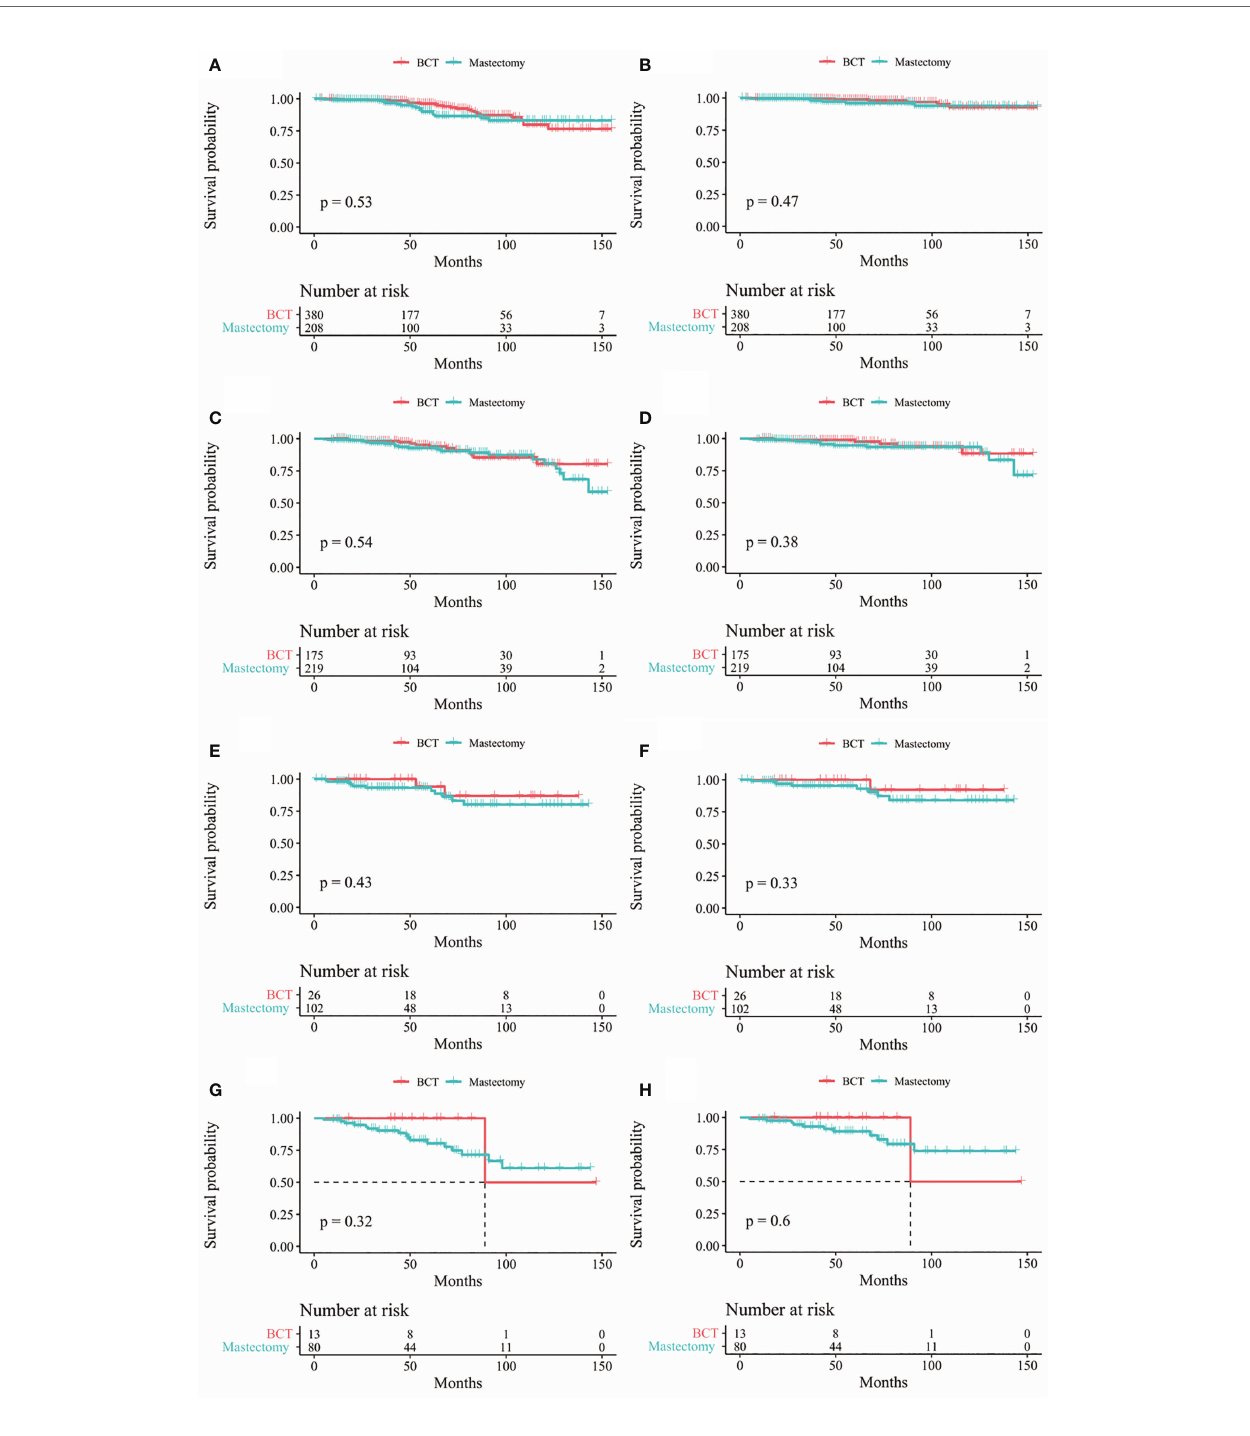
FIGURE 4 | Kaplan-Meier survival curves of subgroup strati fi ed by N stage (A) OS between mastectomy group and BCT group in patients with N0 stage (B) BCSS between mastectomy group and BCT group in patients with N0 stage (C) Os between mastectomy goup and BCT group in patients with N1 stage (D) BCSS between mastectomy group and BCT group in patients with N1 stage (E) Os between mastectomy group and BCT group in patients with N2 stage (F) BCSS between mastectomy group and BCT group in patients with N2 stage (G) OS between mastectomy group and BCT group in patients with N3 stage (H) BCSS between mastectomy group and BCT group in patients with N3 stage. OS, overall survival; BCSS, breast cancer speci fi c survival; BCT, breast conserving